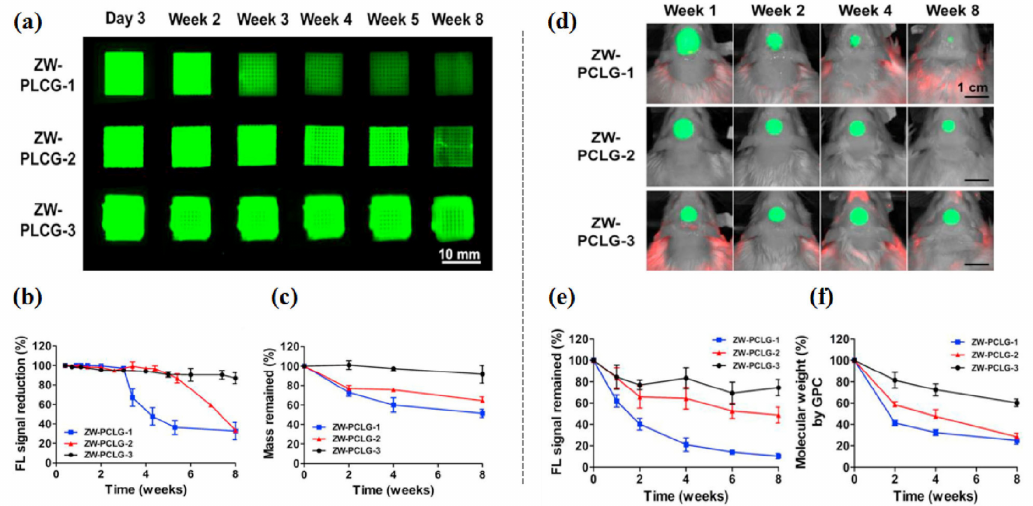
Figure 7. In vitro and in vivo degradation testing of ZW-PCLG copolymers. ( a – c ) In vitro degradation test of ZW-PLCGs with di ff erent monomer ratios. ( a ) NIR fluorescent images of the printed ZW-PCLG sca ff olds under physiological condition. ( b ) Quantification of NIR fluorescence intensity remained in the sca ff olds and ( c ) the remaining mass of the ZW-PCLG sca ff olds. ( d – f ) In vivo noninvasive NIR monitoring for sca ff old degradation. ( d ) NIR images of the ZW-PCLG sca ff olds in the defected calvarial bone of rats at 1, 2, 4, and 8 weeks post-implantation. ( e ) Quantification of the remaining NIR fluorescent intensity in the ZW-PCLG sca ff olds and ( f ) molecular weight changes measured by gel permeation chromatography (GPC). Reproduced with permission from [90].